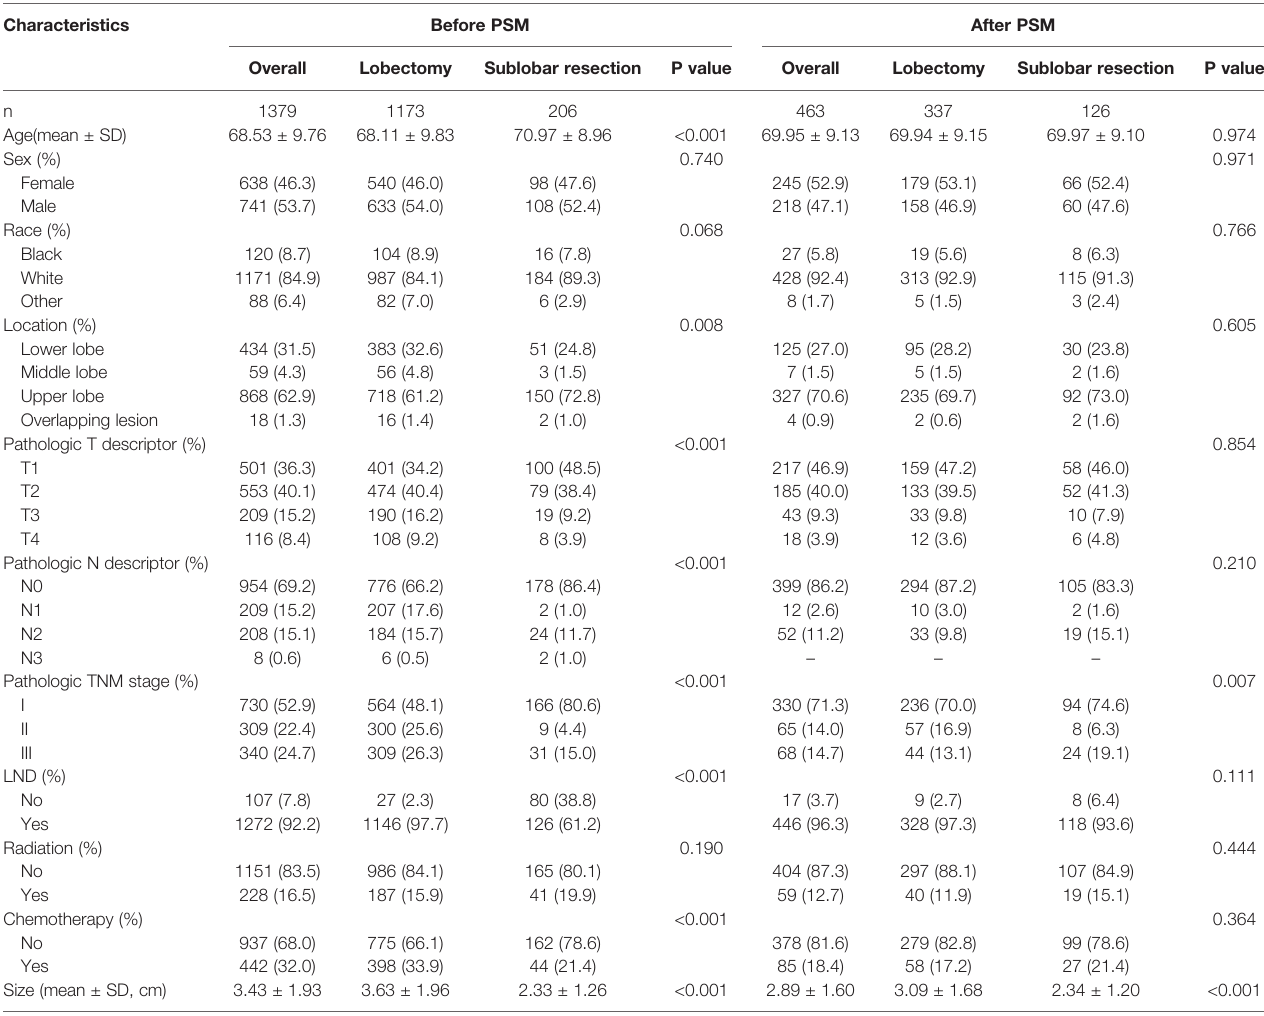
TABLE 1 | Baseline characteristics of the SEER cohort before and after